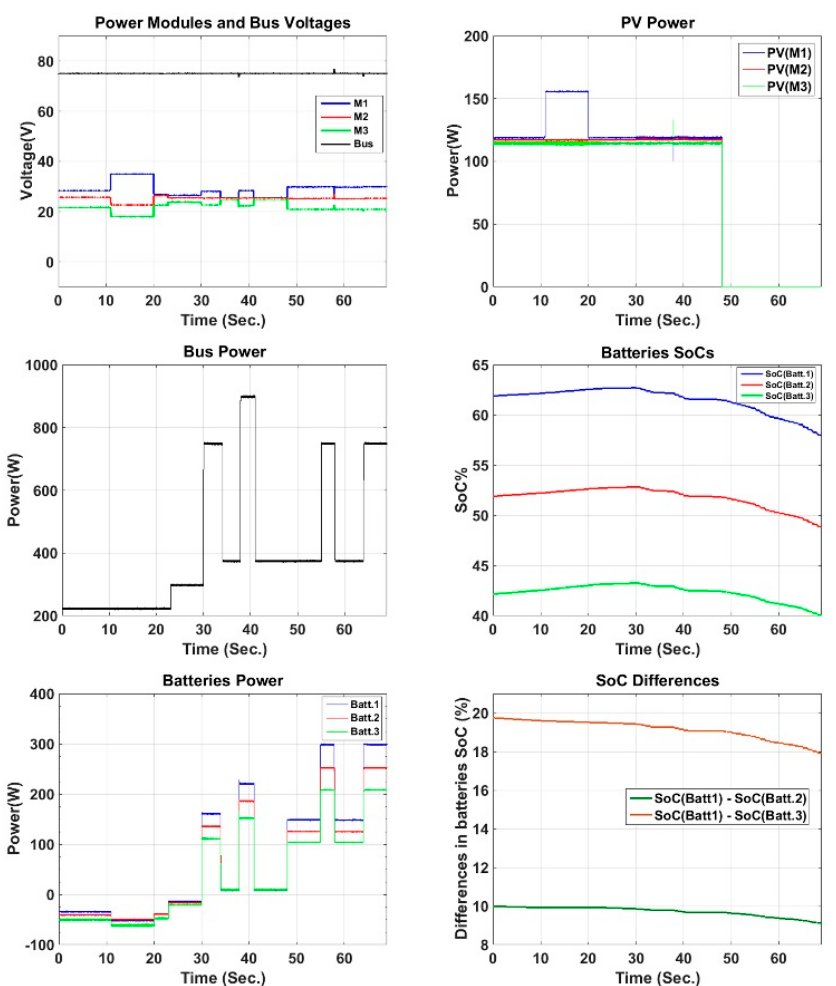
Figure 13. Reducing state of charge imbalance of the battery modules under various conditions (PVs power imbalances, load power surges, no sunlight).